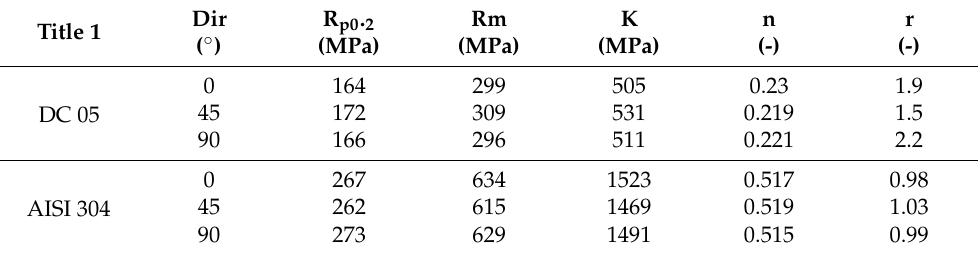
Figure 2. Roughness profile and Abbot–Firestone curve; ( a ) DC 05, and ( b ) AISI 304. Mechanical properties were measured by ISO 6892-1, normal anisotropy ratios by ISO 10 113 at a strain level of 20%, and strain-hardening exponents by ISO 10275 within the strain range 5–20%. A PC-controlled TiraTEST 2300 (TIRA GmbH, Schalkau, Germany) testing machine with extensometers for length and width measurement was used with automated evaluation of the properties shown in Table 2. The chemical composition of both materials is in Table 3. Table 2. Mechanical properties of steels.